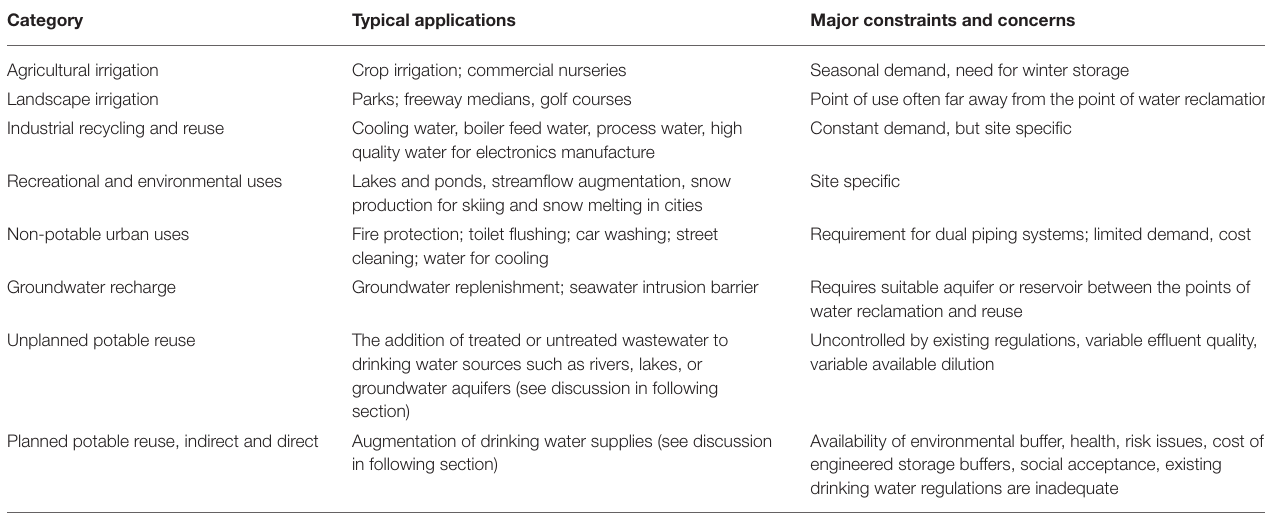
TABLE 2 | Water reuse categories, typical applications, and major constrains and